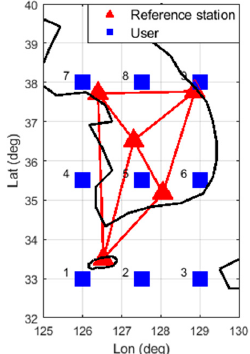
Figure 4. Reference station and user (simulation).